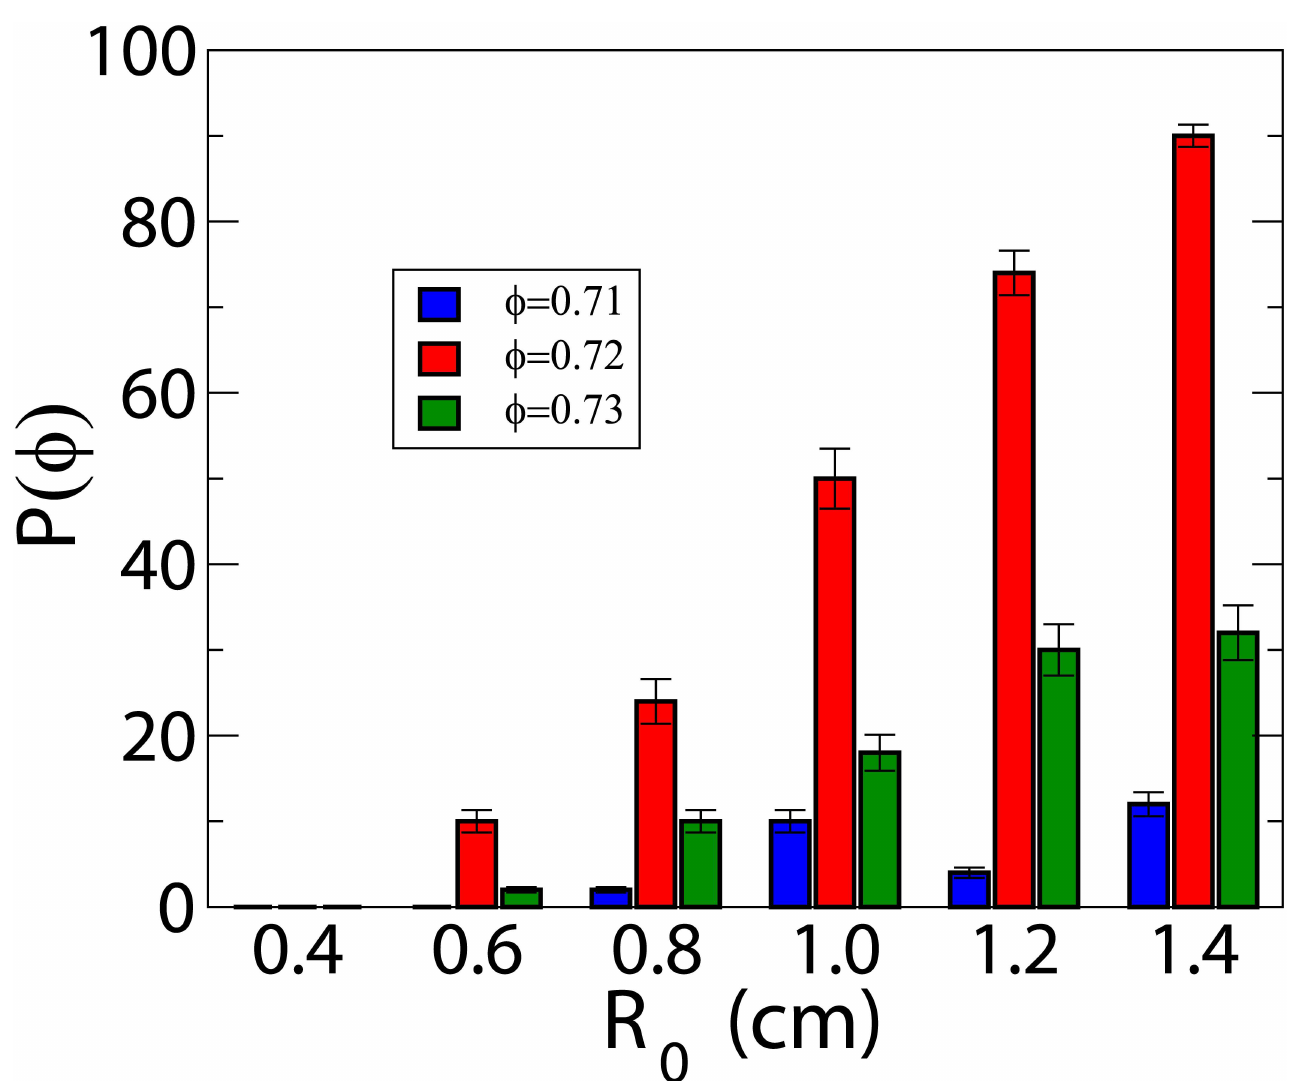
¼ 0 : 30 ms ) and thickness N = 10 layers d